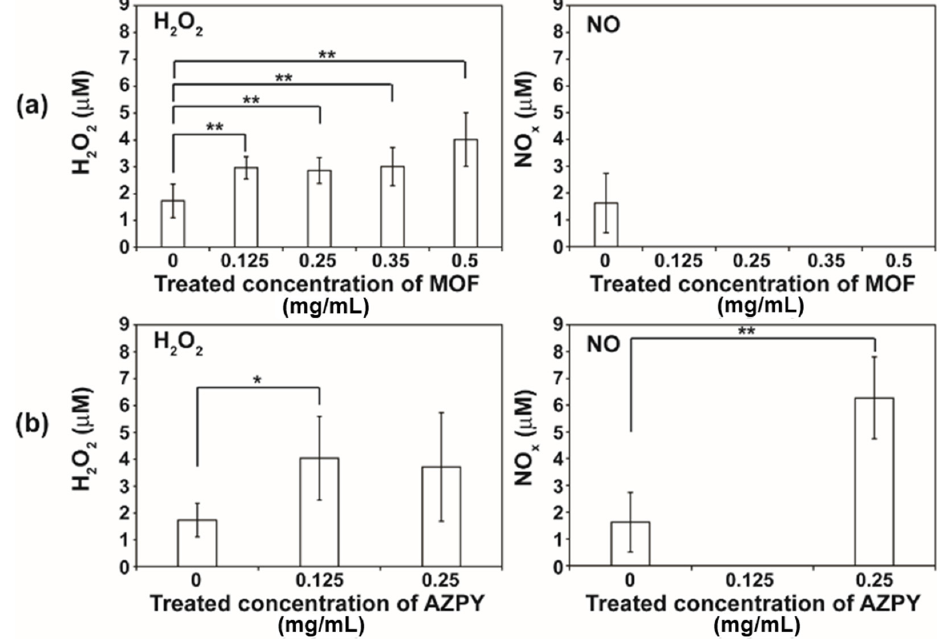
Figure 8. Concentrations of H 2 O 2 and NO in 1 mL of PBS treated with Cu(AZPY)-MOF ( a ) and free AZPY ( b ). * p < 0.05, ** p < 0.01. AZPY ( b ). * p < 0.05, ** p <